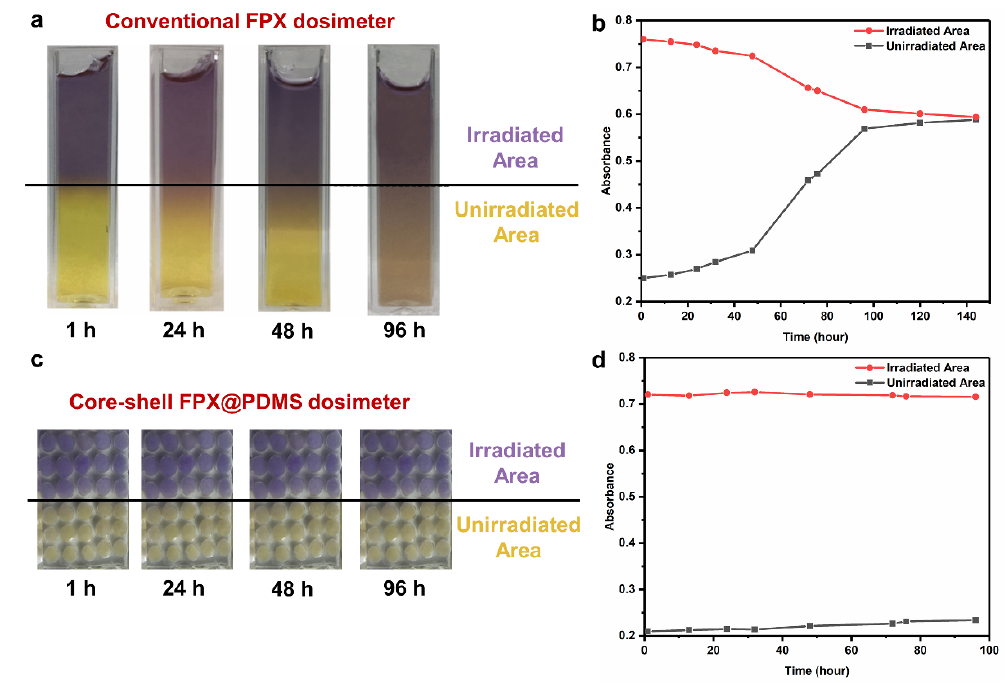
Figure 7. Diffusion comparisons between a conventional FPX dosimeter and a core-shell FPX@PDMS dosimeter. ( a ) Optical photographs of the conventional FPX dosimeter at different times after irradiation. ( b ) Absorbance measurement of diffusion in the conventional FPX dosimeter. ( c ) Optical photograph of the FPX@PDMS dosimeter at different times after irradiation. ( d ) Absorbance measurement of diffusion in the conventional FPX dosimeter.